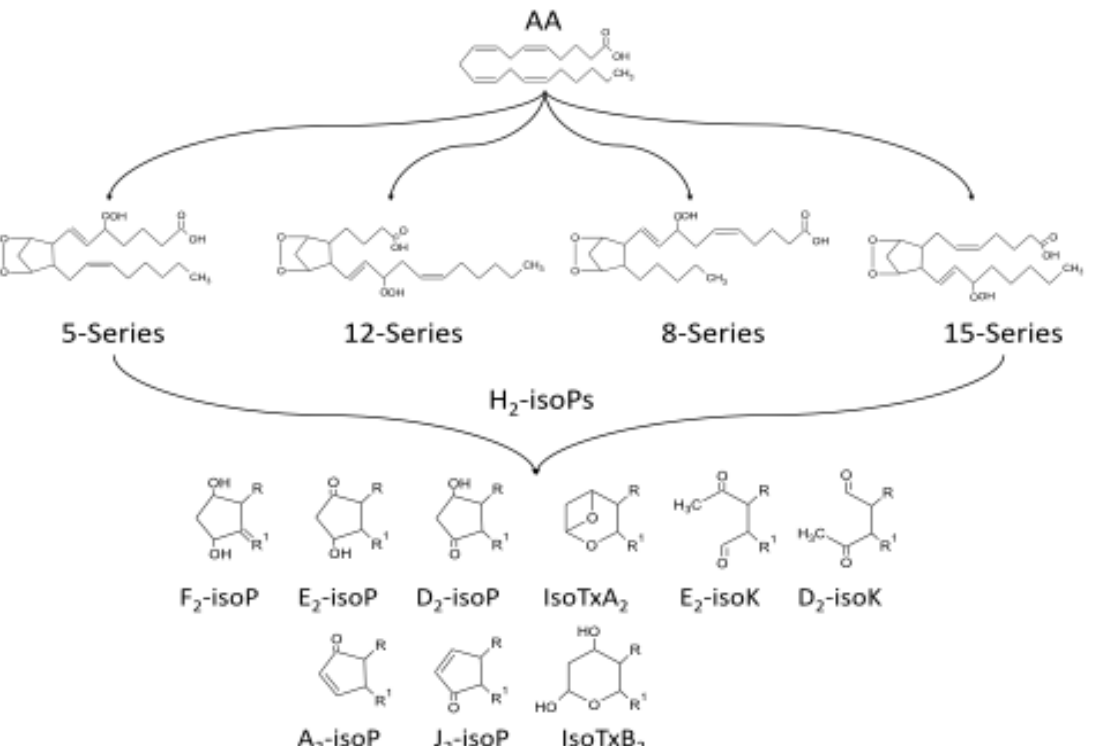
Figure 5. Products of free radical-induced peroxidation of arachidonic